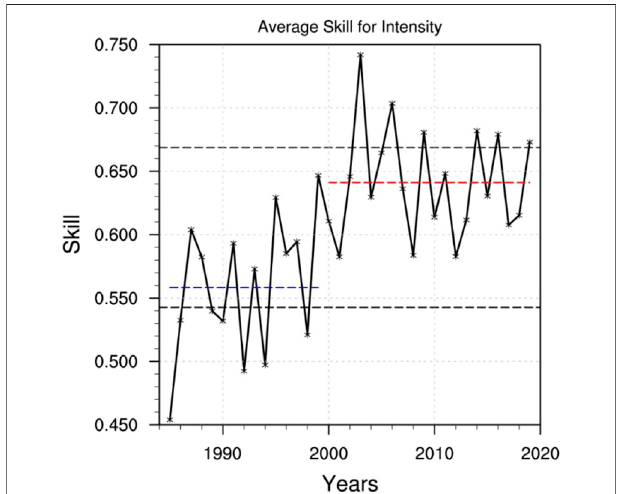
FIGURE 8 | The average prediction skills of the WNPSH intensity index of different lead times as shown in Figure 7 . The two black dotted lines represent that the all-year mean pluses or minuses one standard deviation. The blue dashed line represents the average skill during 1985 – 1999 and the red one does during 2000 – 2019.